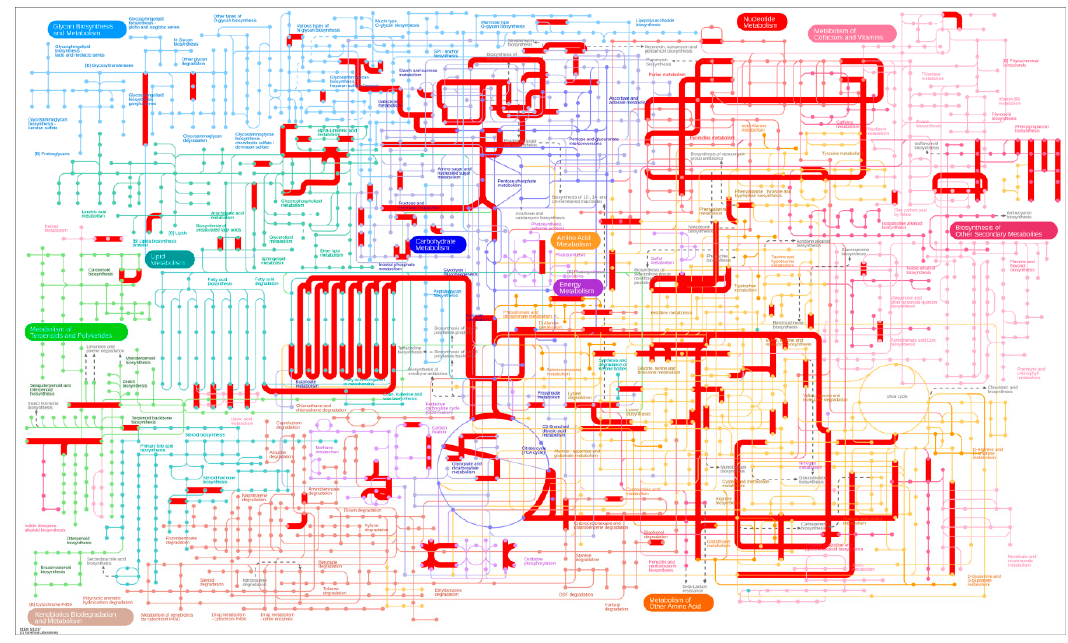
Figure 6. An iPath metabolic map.